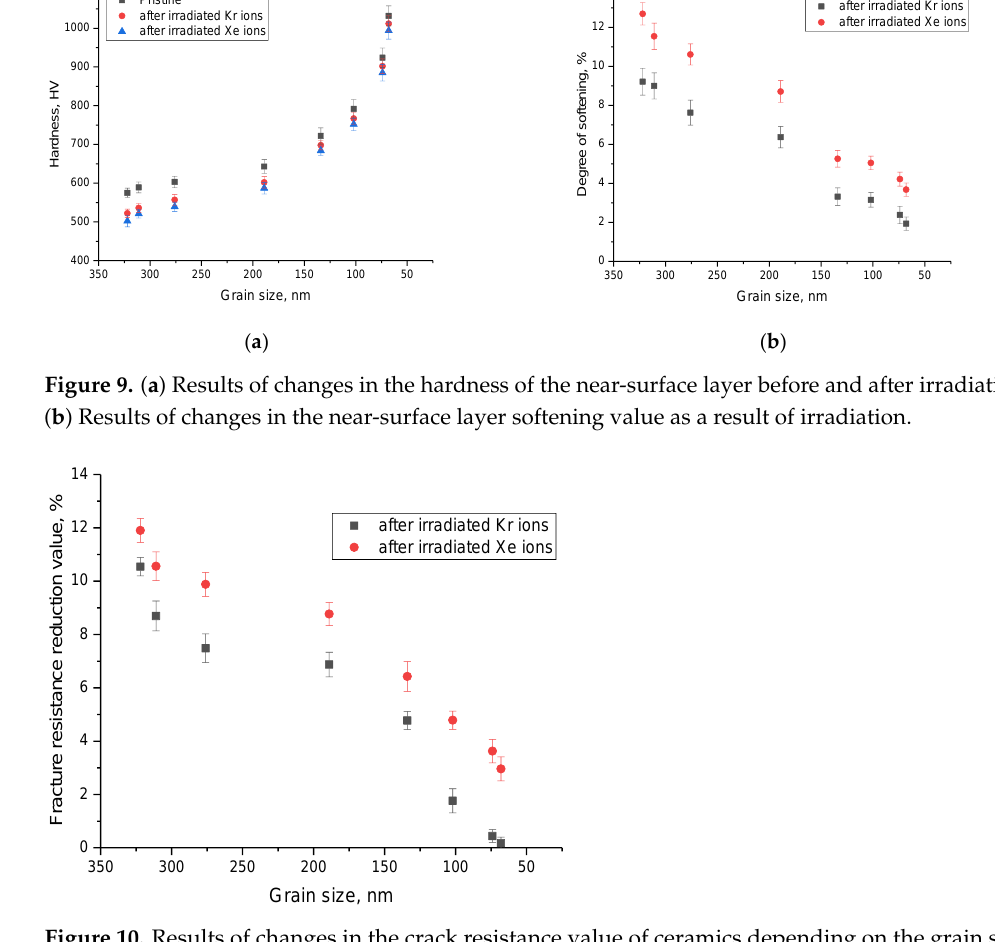
Figure 10. Results of changes in the crack resistance value of ceramics depending on the grain size for both types of